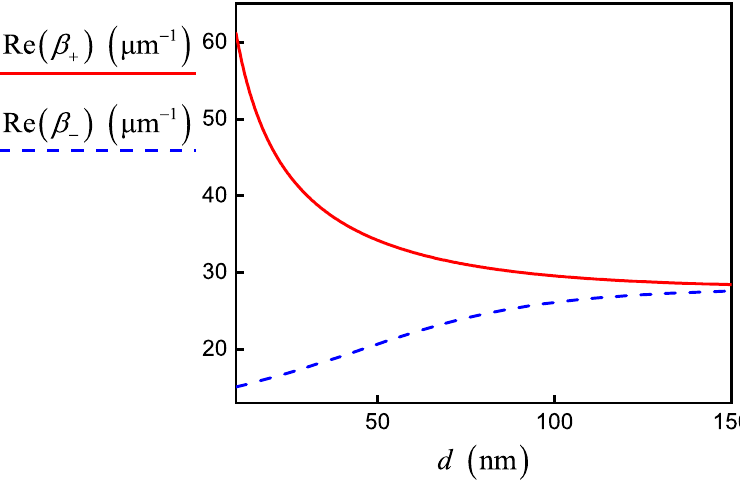
Figure 3. Propagation constants β + (solid red line) and β − (dashed blue line) for signal SPP modes for the double-layer graphene sheets versus the interlayer distance d numerically calculated from Equation (10). Parameters correspond to the strong coupling regime for wavelength 8.04 µm in Table 1.